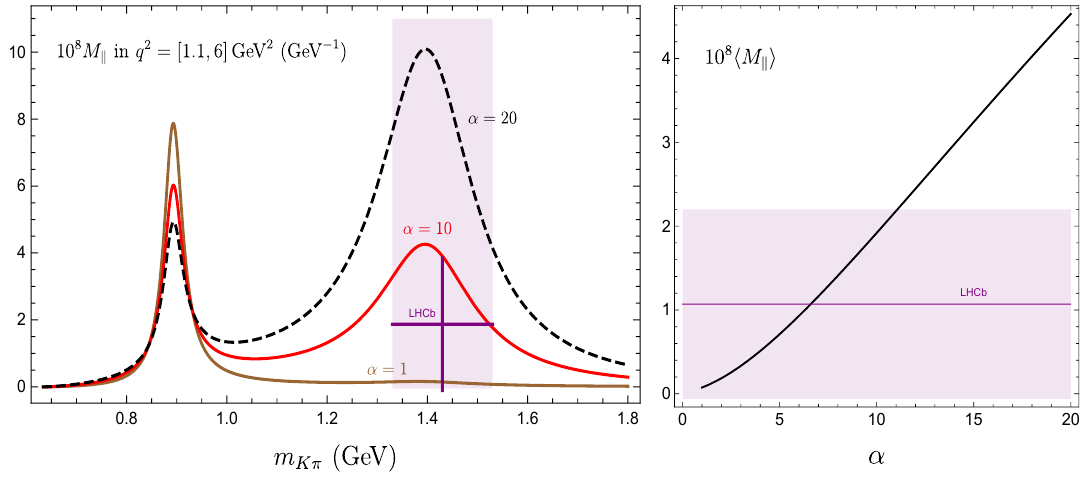
Figure 4 . Left: the moment h M i di(cid:11)erentially in m K(cid:25) for three values of (cid:11) = f 1 ; 10 ; 20 g , compared k to the LHCb measurement in the bin m 2 2 [1 : 33 2 ; 1 : 53 2 ] GeV 2 . For easy comparison, the LHCb K(cid:25) binned measurement has been divided by the bin size. Right: the integrated moment h M function of (cid:11) , compared to the LHCb measurement (horizontal